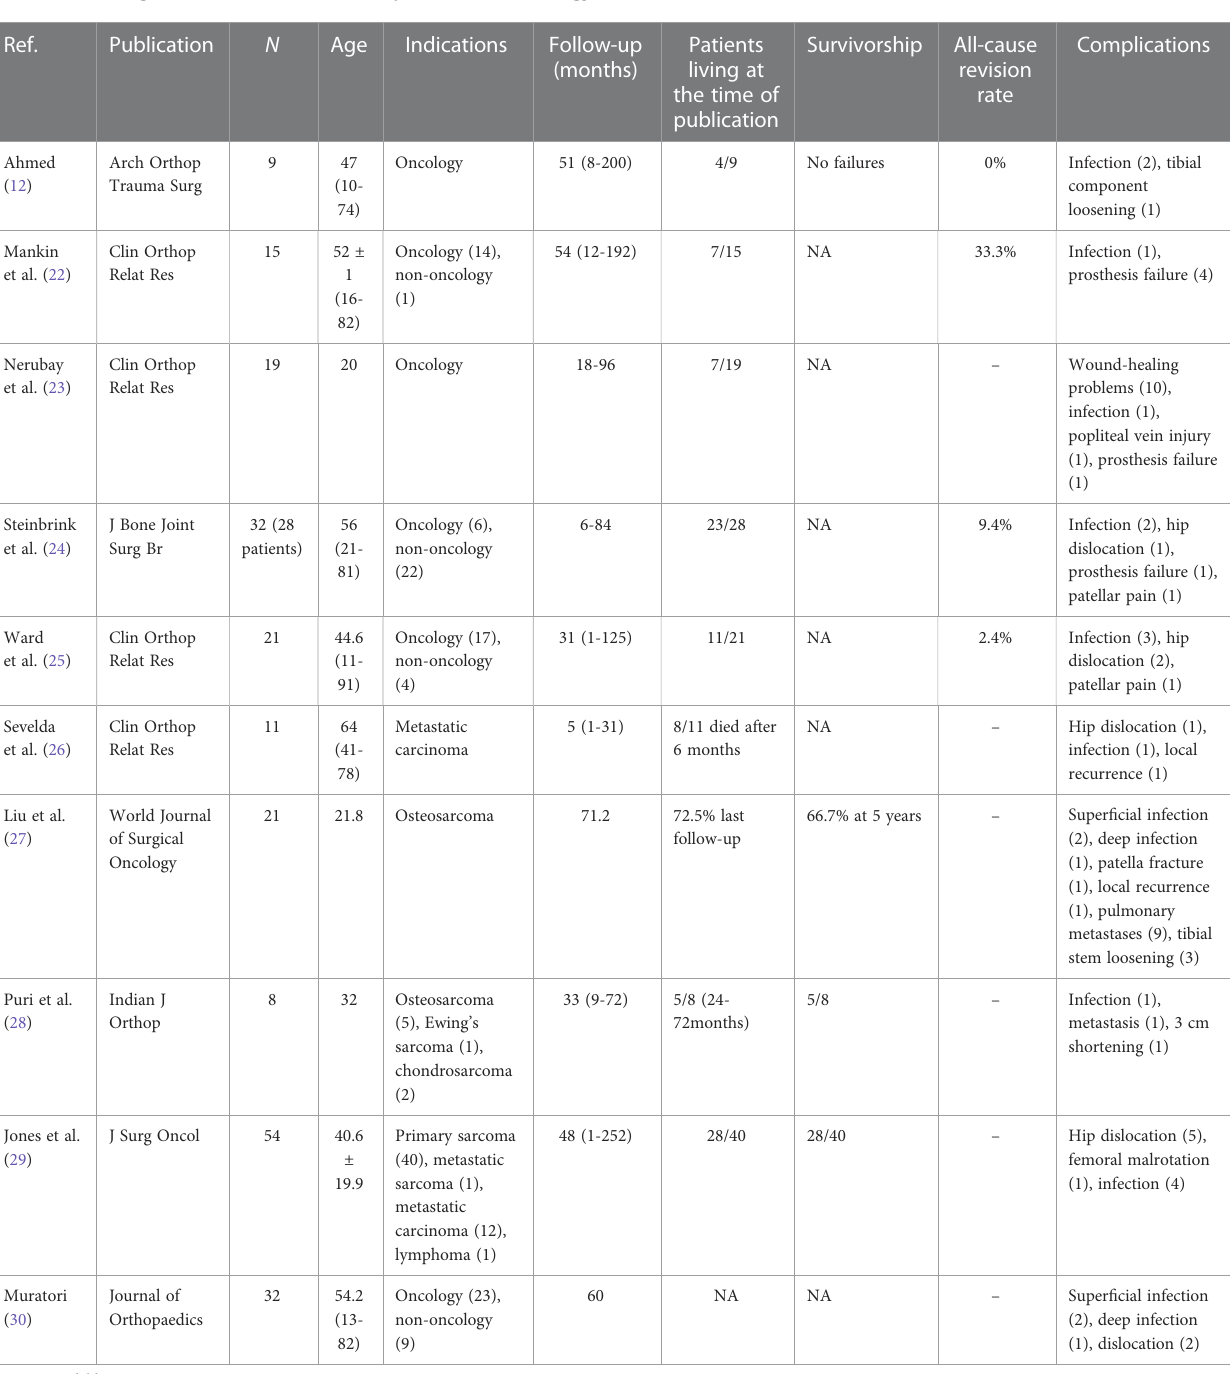
TABLE 4 Main large case series of total femur replacement for oncology in the current literature.